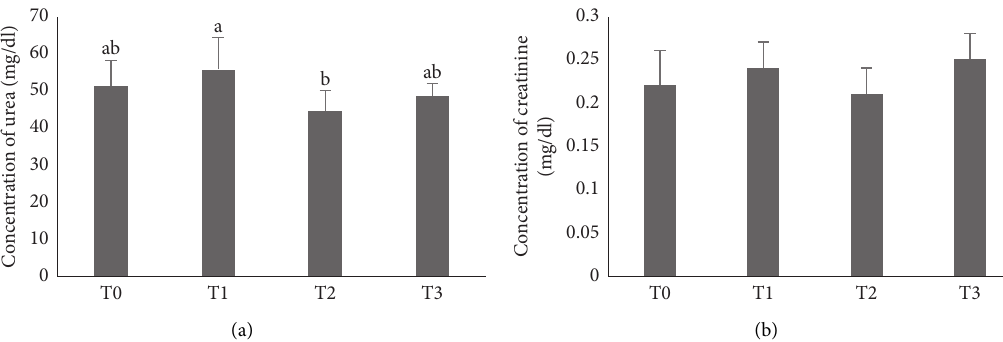
Figure 1: The concentration (mean ± SD) ( n � 6) of urea (a) and creatinine (b) after administration of neem leaf ethanolic extracts in male rats. Different superscripts indicate a statistically significant difference between groups ( p < 0 . 05). T0 � control group, T1 � 100mg/kg treated group, T2 � 200mg/kg treated group, and T3 � 300 mg/kg treated